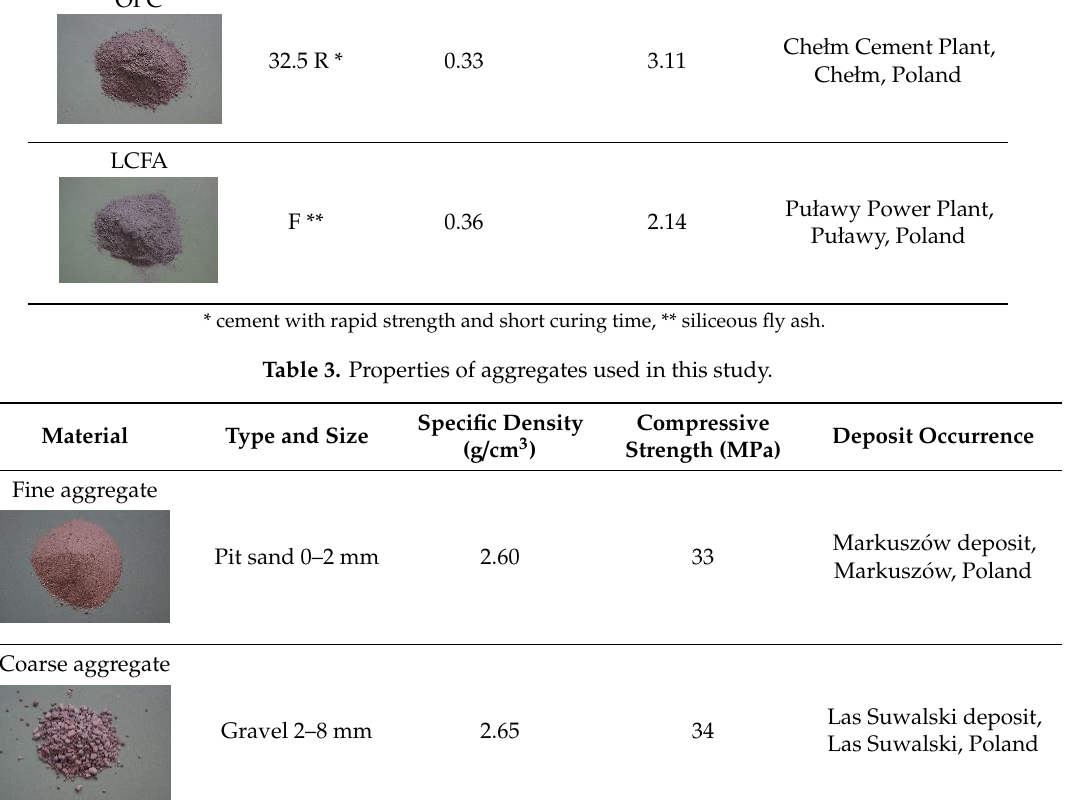
Table 3. Properties of aggregates used in this